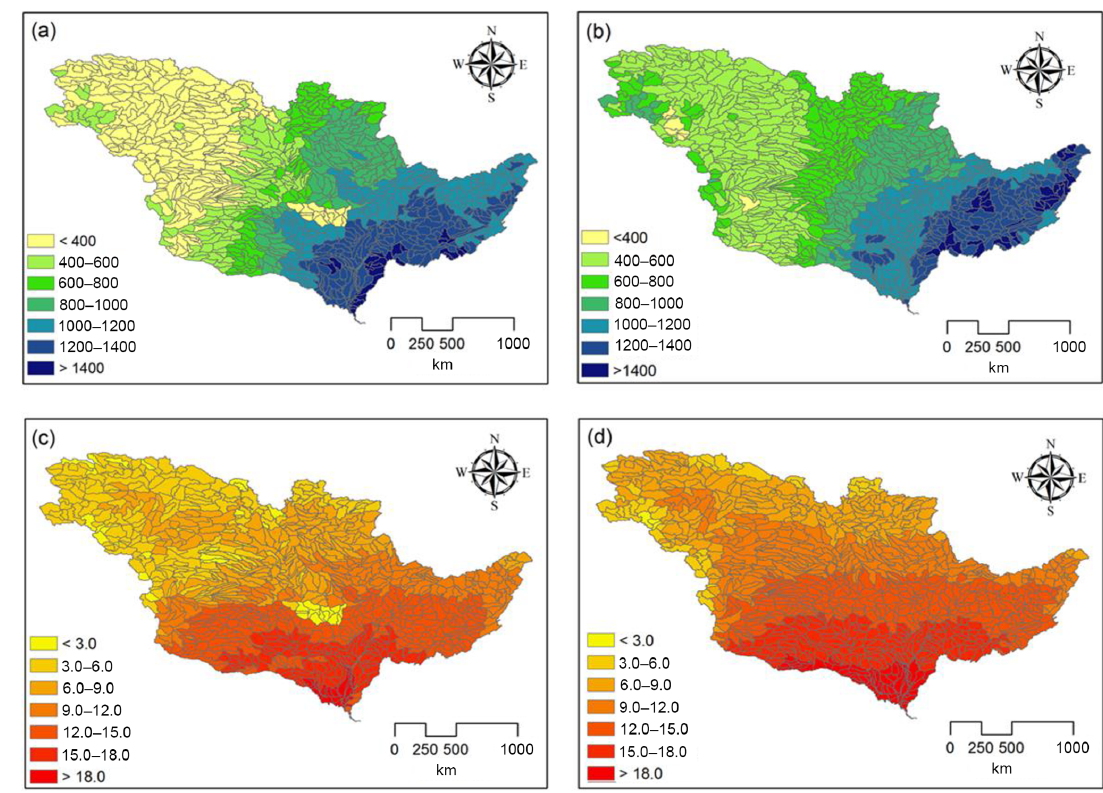
Figure 3. Comparison of average annual precipitation (mm) and temperature ( ◦ C) (2002–2010) between HAWQS and WRF climate at the HUC8 level: (a) HAWQS precipitation, (b) WRF precipitation, (c) HAWQS temperature, and (d) WRF